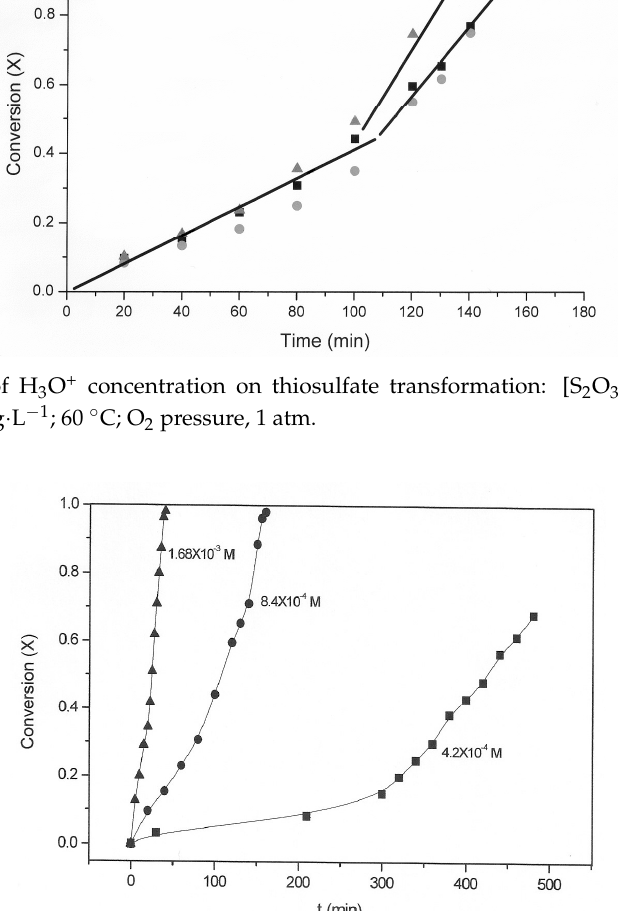
Figure 7. Effect of initial Cu 2+ concentration on thiosulfate transformation: [S 2 O 32− ] initial , 1 g·L −1 ; pH constant , 5; 60 °C; O 2 pressure, 1 atm.